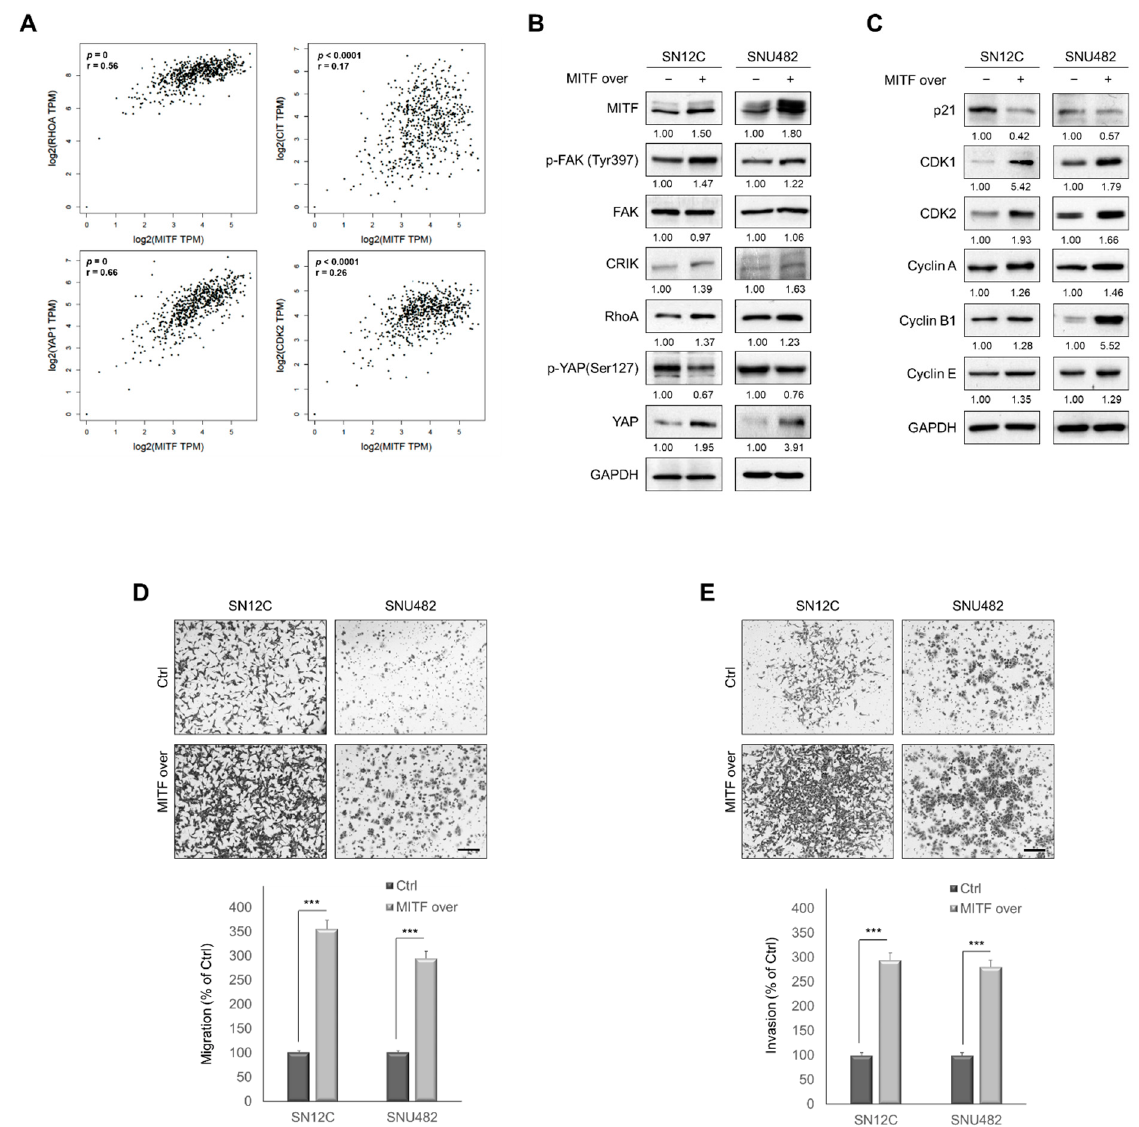
Figure 5. MITF overexpression promotes cell migration and invasion by upregulating RhoA/YAP signaling. ( A ) The four panels (clockwise from top left) show correlation of MITF vs. RhoA, CRIK, CDK2 and YAP1 expression in the GEPIA kidney ccRCC dataset. ( B ) Western blot analysis showing increased expression of phosphorylated FAK, CRIK, RhoA and YAP in MITF-overexpressing cells. Whole areas were measured using Image J software ( n = 3). Uncropped blots are shown in Figure S7. ( C ) Western blot analysis of cell cycle-related proteins. Whole areas were measured using Image J software ( n = 3). Uncropped blots are shown in Figure S7. ( D , E ) Transwell migration and invasion assay showing that MITF overexpression promoted cell migration and invasion. The number of cells in five randomly chosen fields was counted. Data are presented as the means ± standard deviation and were evaluated using Student’s t -test ( n = 3). Scale bar, 200 µm. ***, p < 0.001.